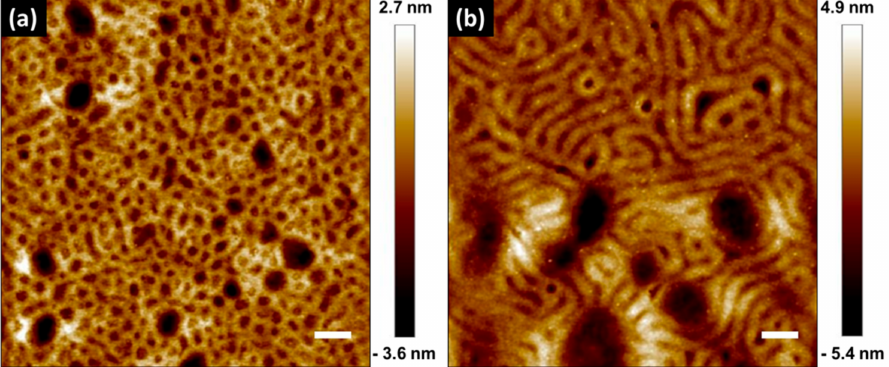
Figure 3. AFM height images of P2 after spin-coating from THF solution on heated Si substrate followed by solvent vapor annealing in ( a ) THF and ( b ) chloroform for 5 min. Scale bars are 200 nm.